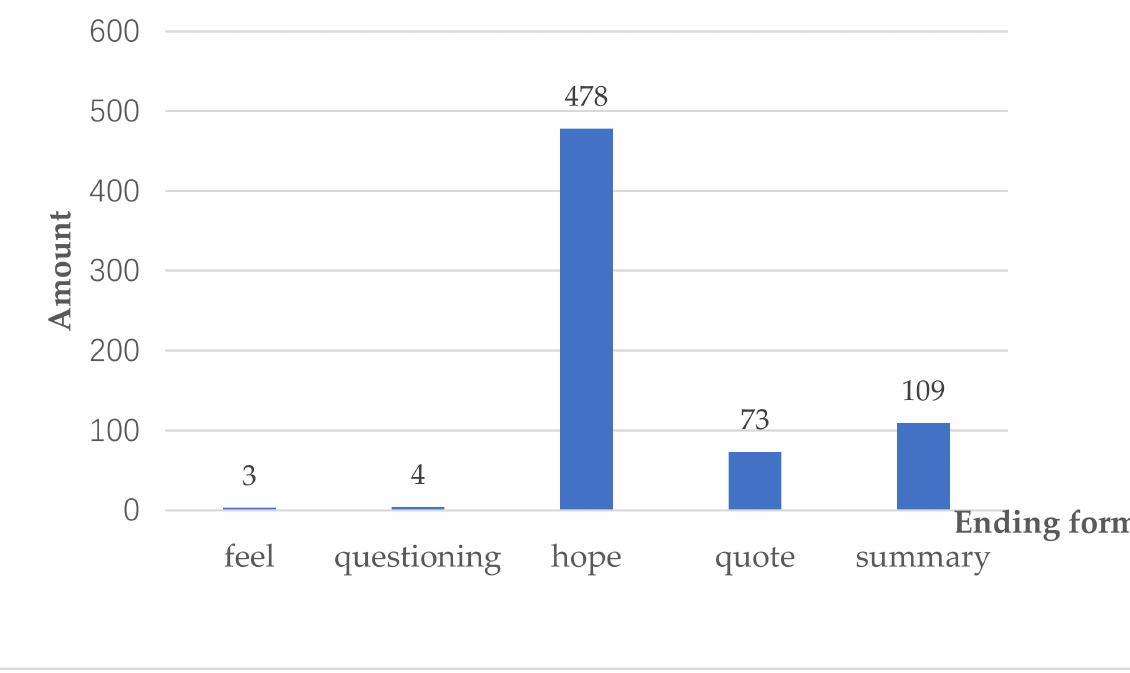
Figure 6. Clustered histogram of the ending form of YiXi